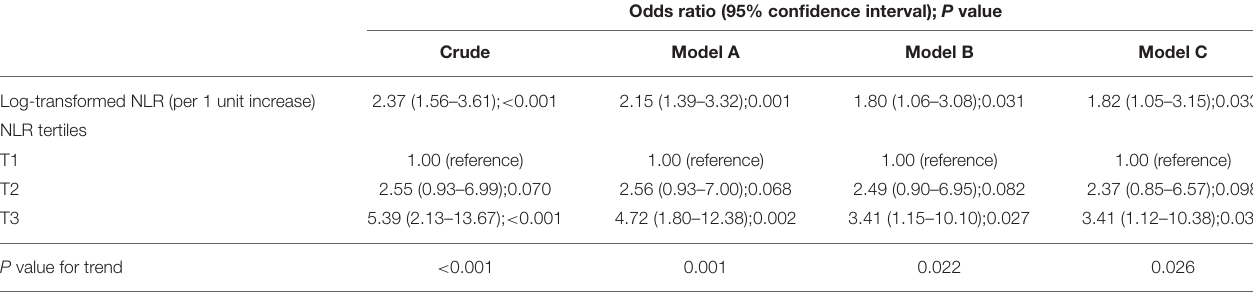
TABLE 2 | The association between NLR and treatment failure in GEE